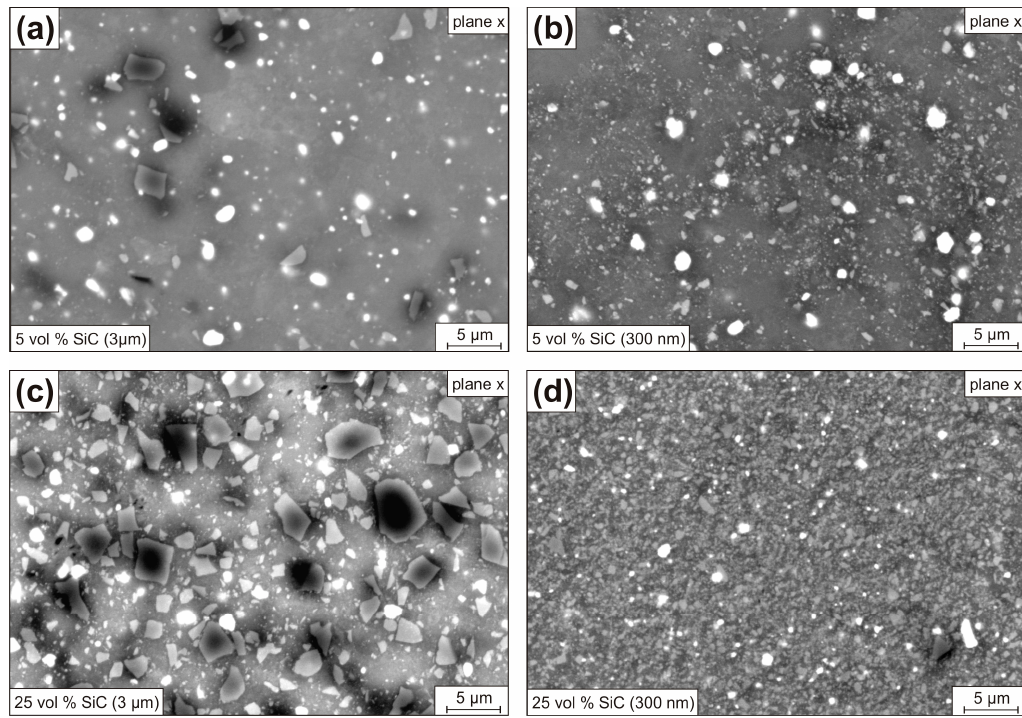
Figure 3. QBSD micrographs of the 2124 aluminum alloy reinforced with ( a , b ) 5 vol % and ( c , d ) 25 vol % SiC particles with a size of ( a , c ) 3 µ m and ( b , d ) 300 nm. The SiC particles are irregularly shaped and finely dispersed: Matrix and particles exhibit an intact interface.